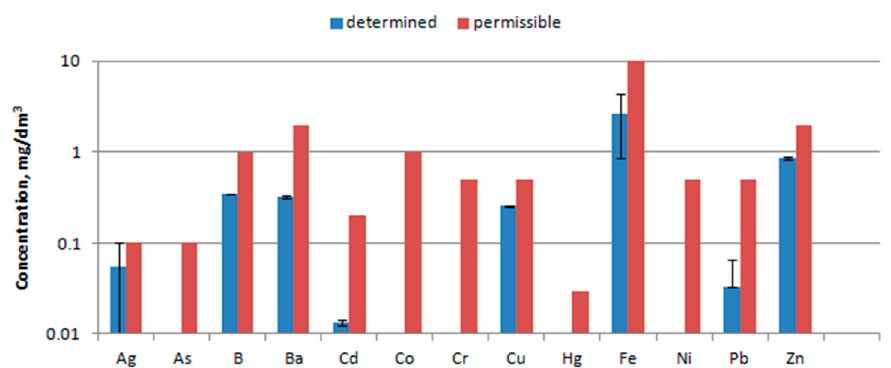
Figure 6. Concentration of heavy metals in PETWW water extract.